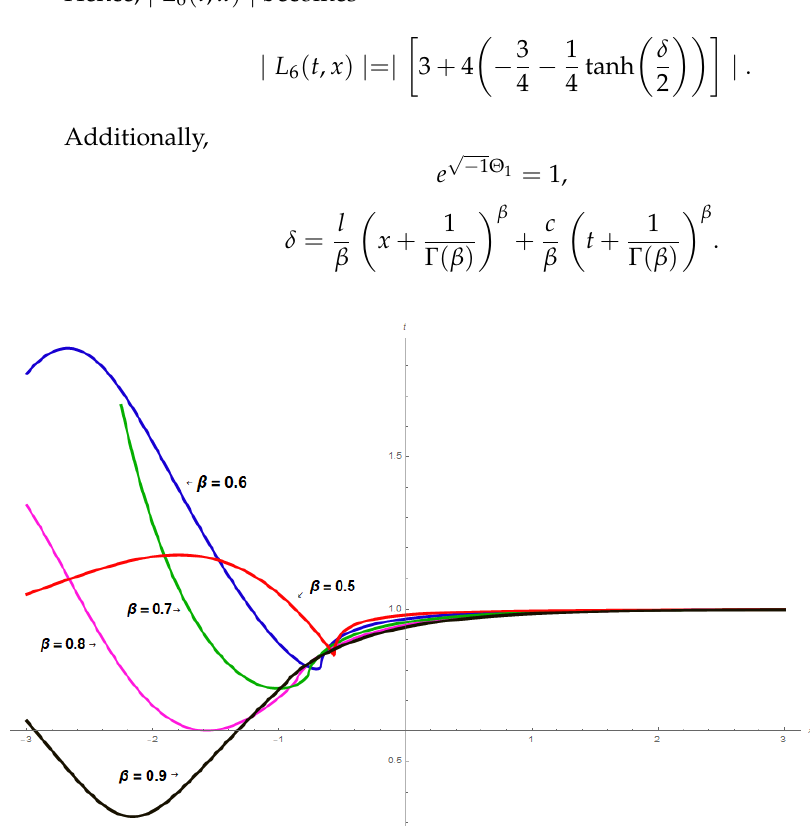
Figure 1. The 2D graphs of dark solitary waves solution, i.e., | L 6 | across different values of β . Figure 2: The analytical solution | L 10 ( t , x ) | is based on the constant values of the proposed parameters. | L 10 ( t , x ) | is graphically illustrated to demonstrate the potentiality of the EDAT with the fractional beta derivative as follows. This illustration portrays a realistic representation of | L 10 ( t , x ) | which is linked to the category of dark,